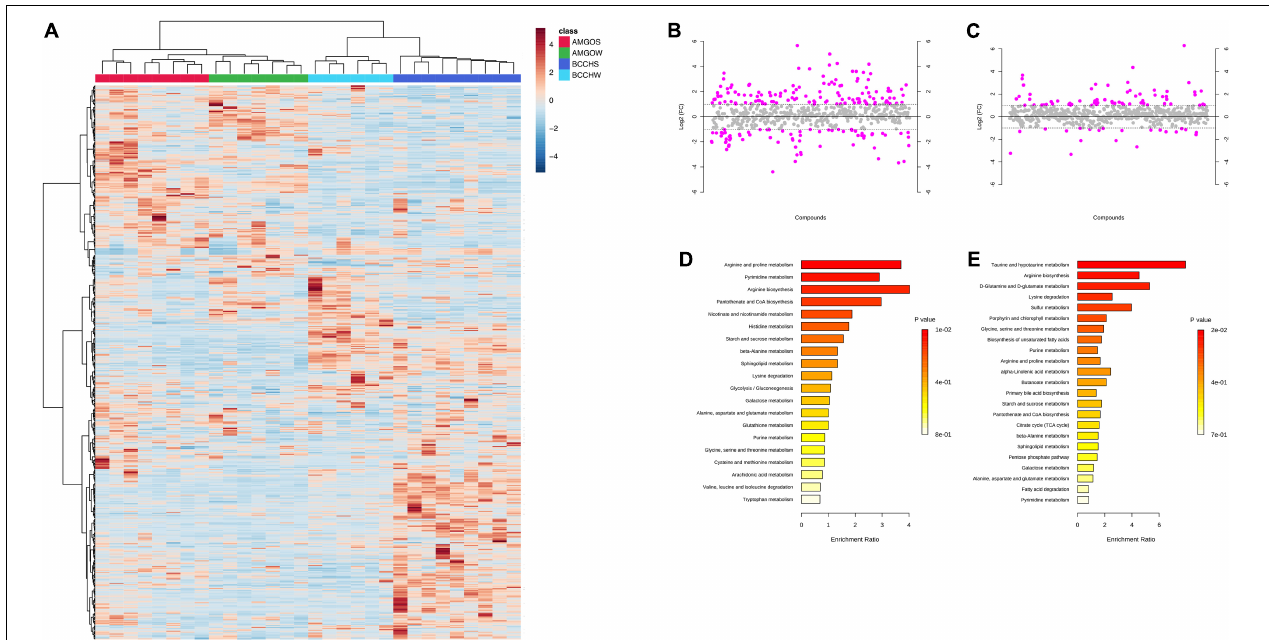
FIGURE 2 | Metabolite abundances in pectoralis muscle in Black-Capped Chickadee (BCCH) and American Goldfinch (AMGO) during Summer and Winter. (A) Clustered by seasons, where class color at the top of the heatmap represents samples/individuals, and the vertical dendrogram indicates individual metabolites and their relations to each other; blue = BCCHS – Black-Capped Chickadee Summer; light blue = BCCHW –Black-Capped Chickadee Winter, red = AMGOS – American Goldfinch Summer, green = AMGOW – American Goldfinch Winter. Color in the heatmaps reflects the relative metabolite abundance: red represents metabolite abundances higher than the mean and blue represents metabolite abundances lower than the mean. Metabolites with greater than twofold increase in the (B) black-capped chickadee (Winter compared to Summer, Supplementary Table 1 ) and the (C) American Goldfinch (winter vs. summer; Supplementary Table 2 ). Significantly enriched ( P < 0.05) metabolic pathways according to metabolites with greater than twofold increase in the (D) black-capped chickadee (Winter compared to Summer) and the (E) American goldfinch (Winter compared to